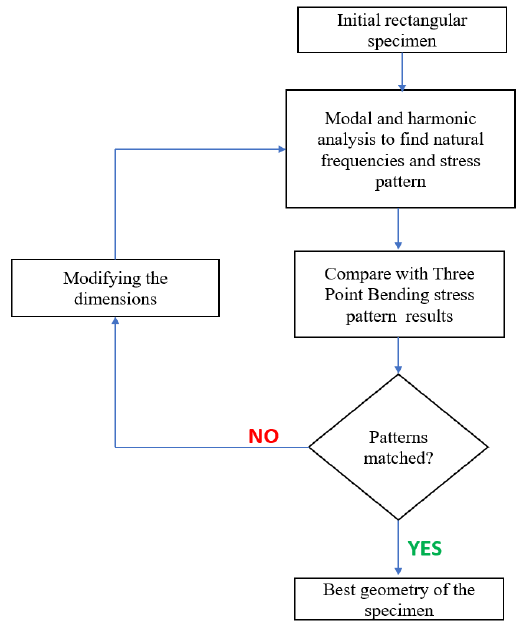
Figure 4. Approach used in the optimization design of the vibration specimen.